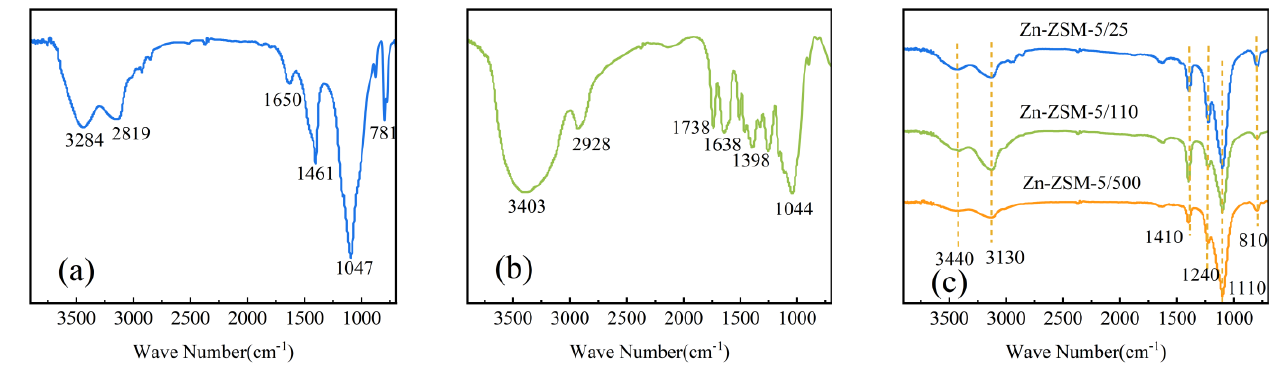
Figure 1. FTIR spectra of ( a ) OS, ( b ) WS, and ( c ) catalysts.